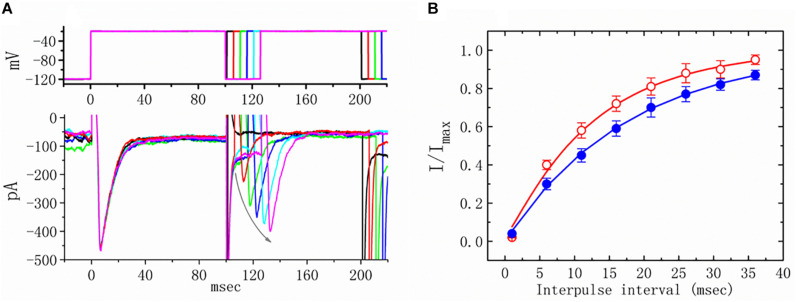
Effects of telmisartan (TEL) on the recovery of INa from inactivation in mHippoE-14 neurons. Cells bathed in Ca2+-free Tyrode’s solution were briefly depolarized from −120 to −20 mV with a duration of 100 ms, and various interpulse durations were applied (indicated in the upper part of panel A). In (A), an example of current traces obtained with a two-pulse protocol in the presence of TEL (3 μM) is illustrated. Noticeably, the curved gray arrow shown in (A) indicates the direction of INa recovery. (B) Time course of recovery from inactivation of INa in the absence or presence of 3 μM TEL (mean ± SEM; n = 12–14 for each point). The time course in the absence or presence of TEL (3 μM) was fitted to a single exponential with a time constant of either 17.7 or 12.5 ms, respectively.